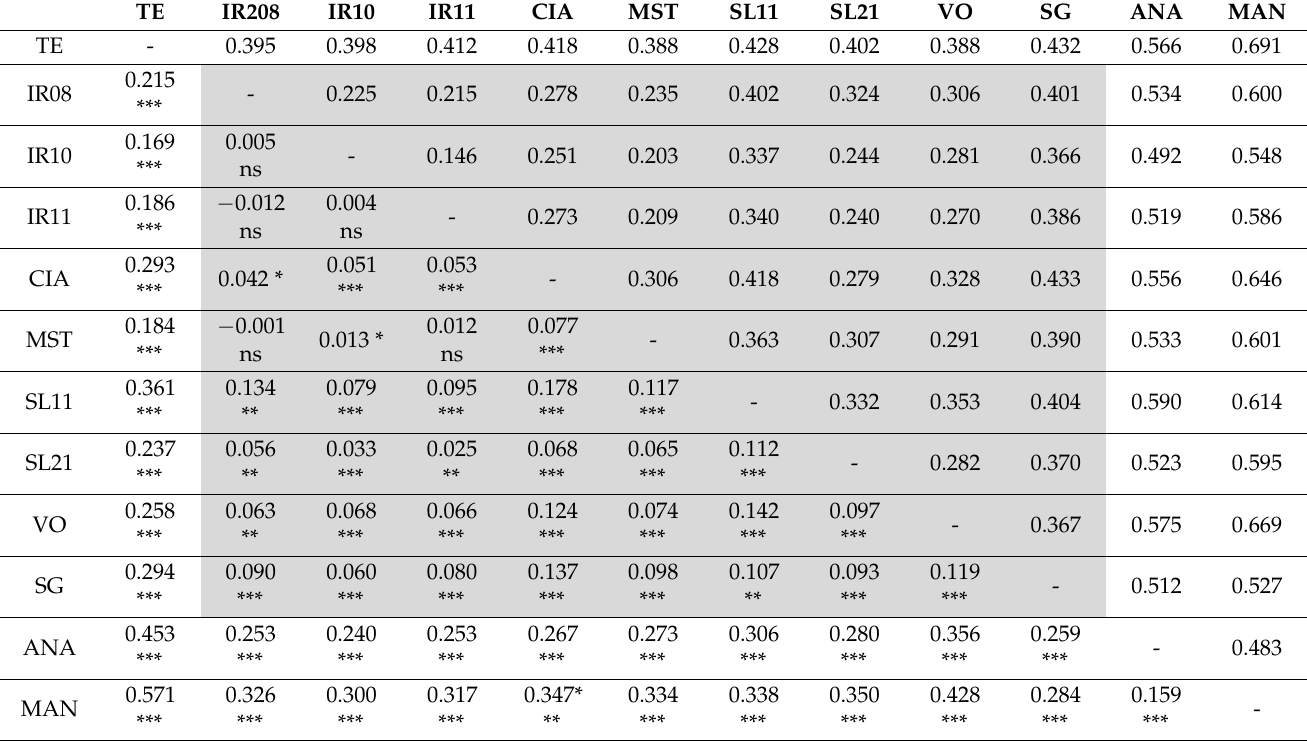
Table 2. Pairwise genetic differentiation. Above diagonal: CS [30]. Below diagonal: F ST and its